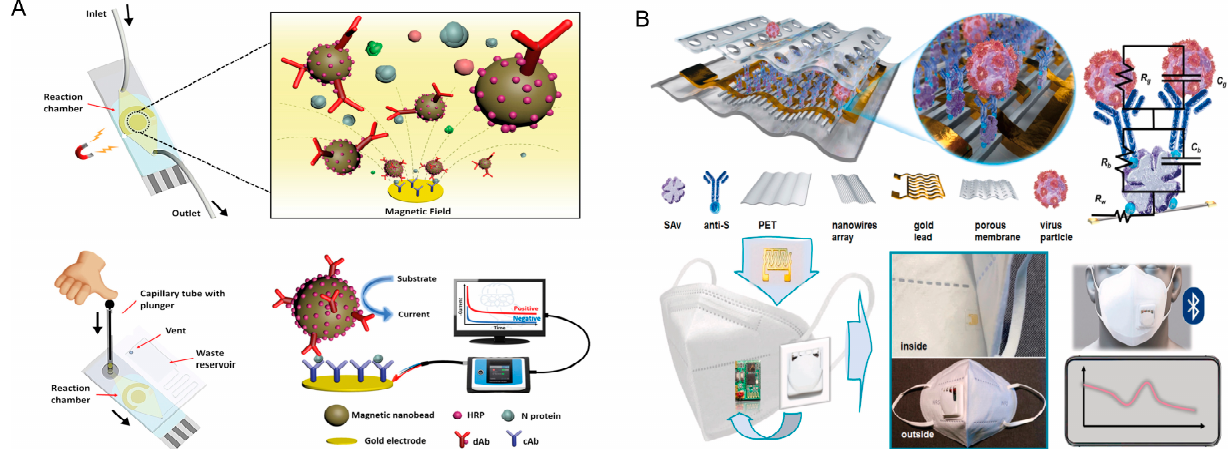
Figure 5. SARS-CoV-2 antigen detection in serum and droplets. ( A ) Microfluidic device for the high-sensitivity measurement of N protein in undiluted and 5× diluted serum. Reprinted with permission from [43], 2021 American Chemical Society; ( B ) immunosensor for the detection of SARS-CoV-2 in droplets by exploiting the surface of the face mask to collect and enrich the respiratory droplets. Reprinted with permission from [47], 2021 Elsevier.